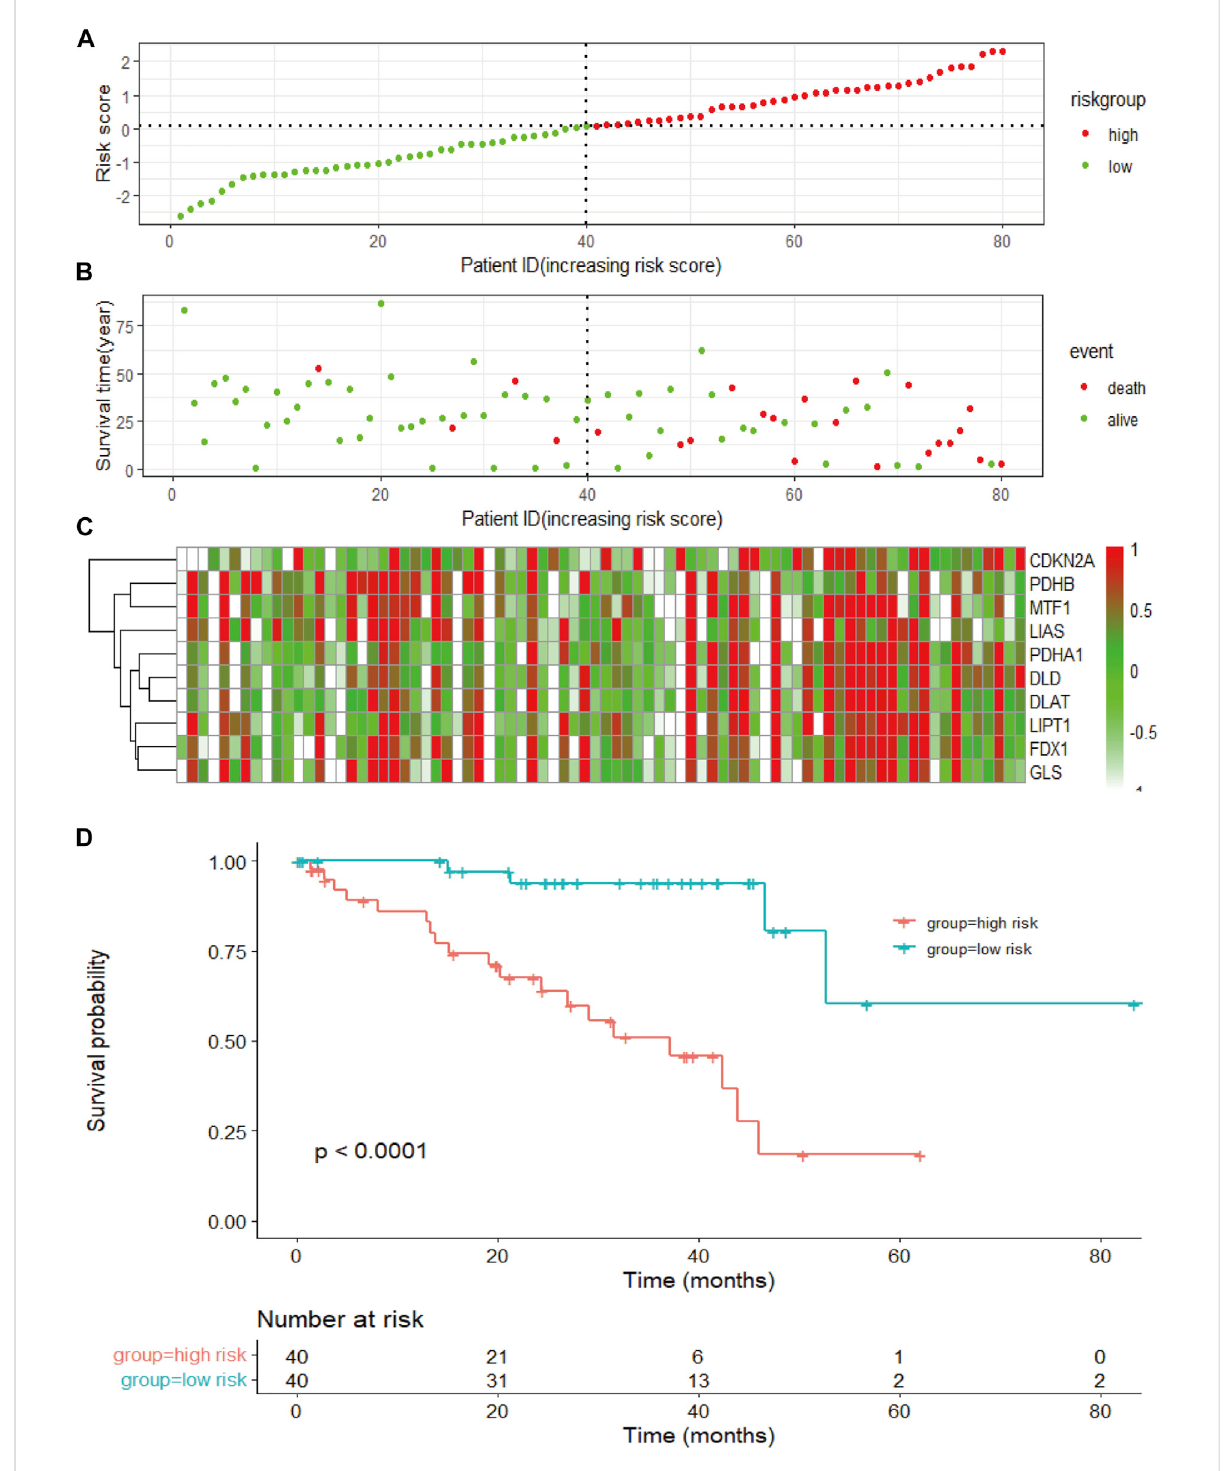
FIGURE 3 The risk score of thesignature and survival intheTCGA cohort. (A) The risk score, survival time, and survival status of patients with UVM. (B) The scatter plot distribution represents the risk score of patients with UVM corresponding to the survival time and survival status. (C) The heatmap presents theexpression oftheeightselectedCRGs inpatients withUVM. (D) Kaplan-Meiersurvivalanalysis using thelog-ranktestfor comparisonof different groups within the risk